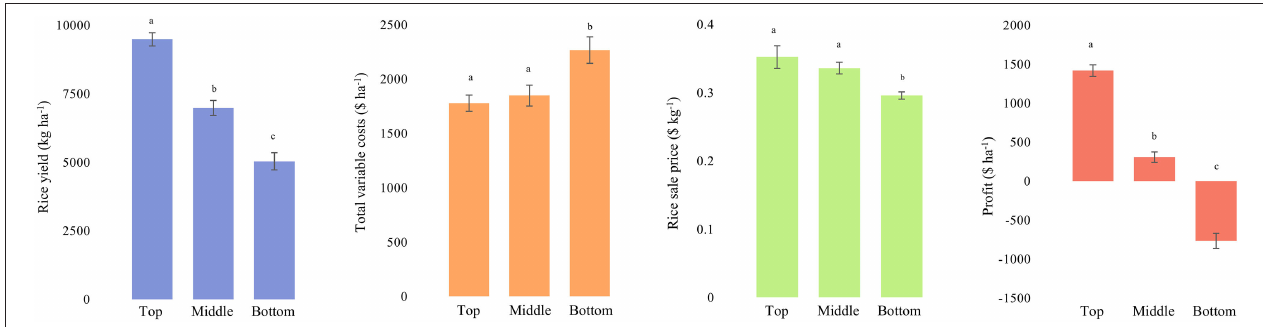
Frontiers in Sustainable Food Systems |